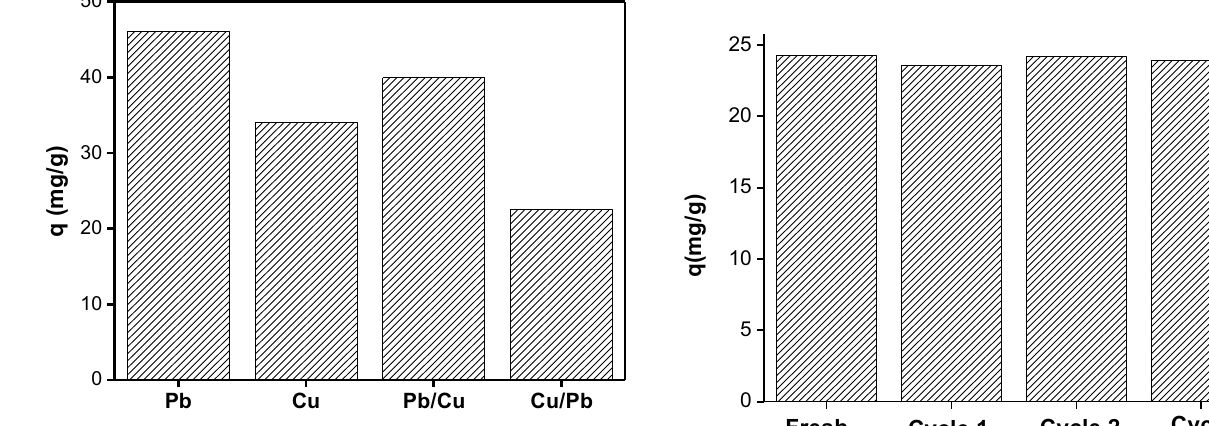
3 PO 4 -600 2:3 as func-